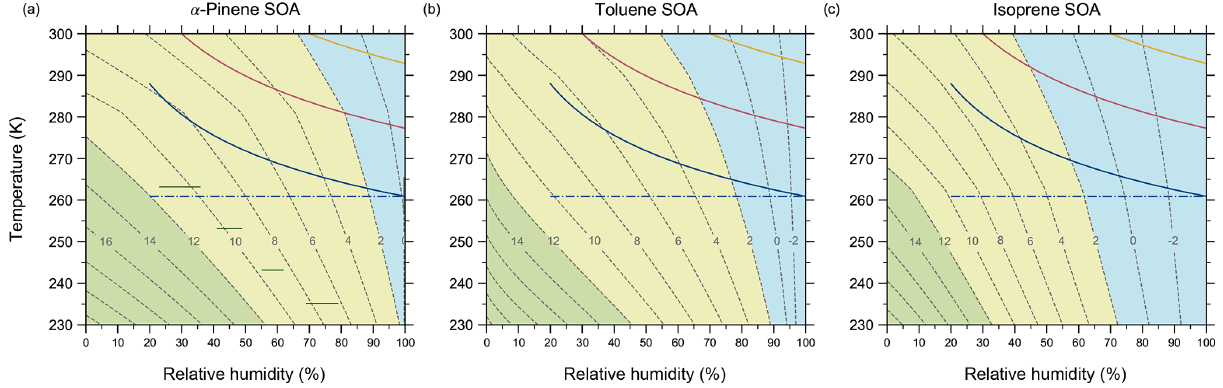
Figure 8. Mixture viscosity predicted by AIOMFAC-VISC as a function of temperature and relative humidity for simulated (a) α -pinene SOA, (b) toluene SOA, and (c) isoprene SOA. Dashed contour lines denote the values of log 10 (η mix Pas ) . Coloured regions indicate conven- tional, viscosity-based classifications of liquid (blue), semi-solid (yellow), and amorphous solid (green) physical states. The green horizontal lines in (a) denote ranges of RH and T for which Järvinen et al. (2016) measured a viscosity “phase” transition from solid or semi-solid to liquid in α -pinene SOA. They determined this viscosity transition to occur at η mix = 10 7 Pas. The solid coloured lines indicate three tra- jectories in temperature versus RH space for an idealized adiabatic air parcel uplift containing SOA particles for different initial conditions. The assigned initial conditions are T = 288K, RH = 20% (blue); T = 300K, RH = 30% (pink); and T = 300K, RH = 70% (yellow). The dash-dotted blue line depicts the possible range of relative humidity experienced by SOA particles should they survive cloud processing and remain at their saturation